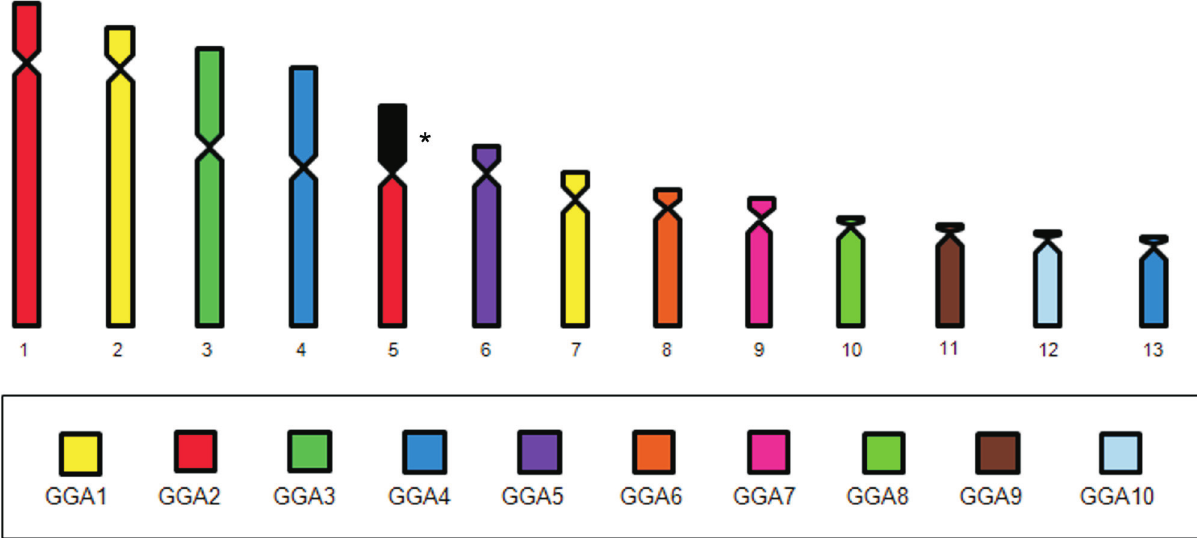
Figure 3 - Homology map of Conopophaga lineata with Gallus gallus (GGA) probes indicated by color. *Not hybridized segment with any GGA probes